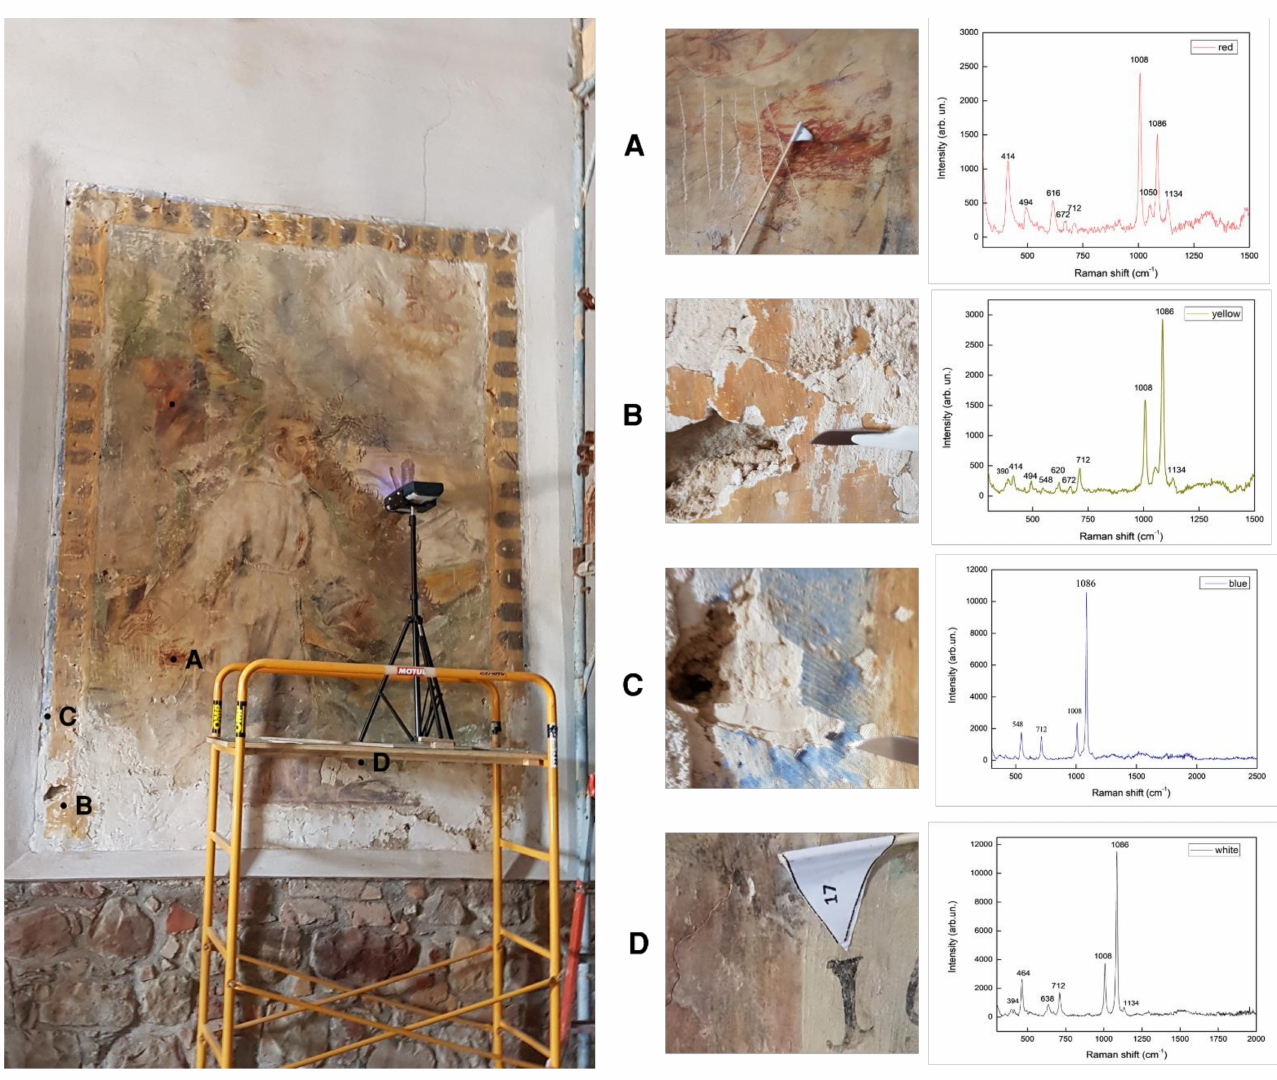
Figure 11. The figure shows four representative points (of 18 totals [31]) measured with Raman Spectrometer and the related spectra: ( A ) = white; ( B ) = yellow; ( C ) = blue; ( D ) = white. For each point a zoom is shown in the left part of the image, next to its related